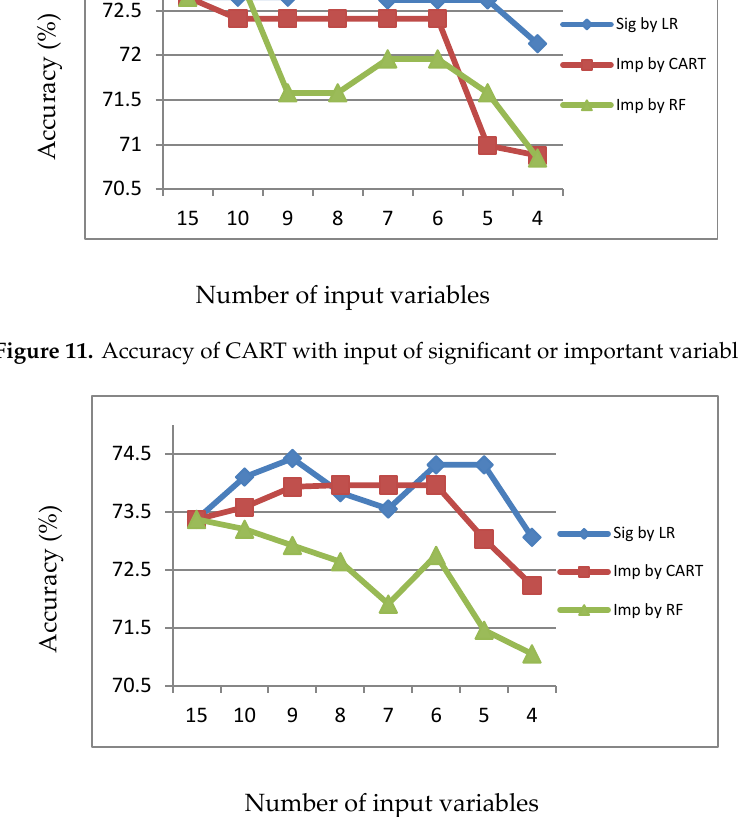
Figure 12. Accuracy of RF with input of significant or important variables.